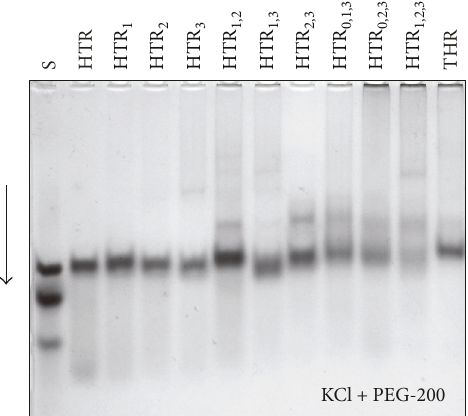
Figure 8: Electrophoretic record of DNA oligonucleotides in the presence of PEG-200. Electrophoretic gel and buffer contained 50 mM KCl. DNA samples were heated to 95 ∘ C for 5 min, slowly cooled, and then loaded into the electrophoretic wells. 0.4 𝜇 L of DNA from 1mM stock solution was applied to each electrophoretic well ( ∼ 3 𝜇 M). The loading buffer contained 50 wt%